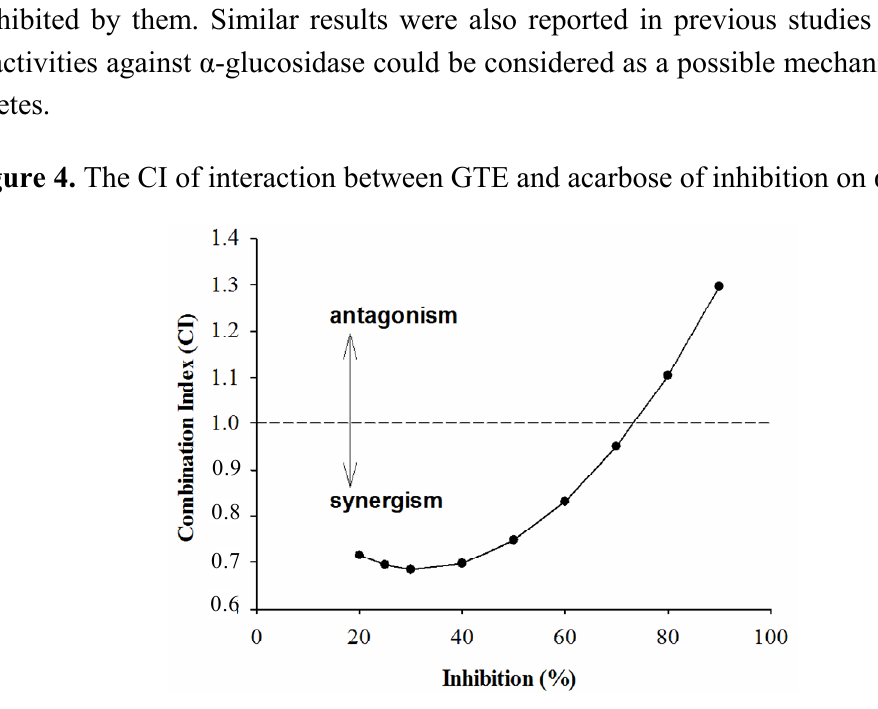
Figure 5. The CI of interaction between GTP and acarbose of inhibition on α